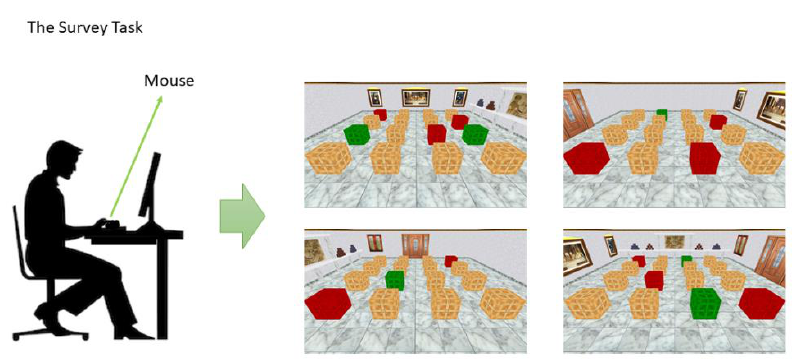
Figure 2. Four examples of the Survey Task in the virtual room. Participant saw the same virtual room as in the Route task, but from different points of view and could not move around. They could use a mouse to select the boxes to